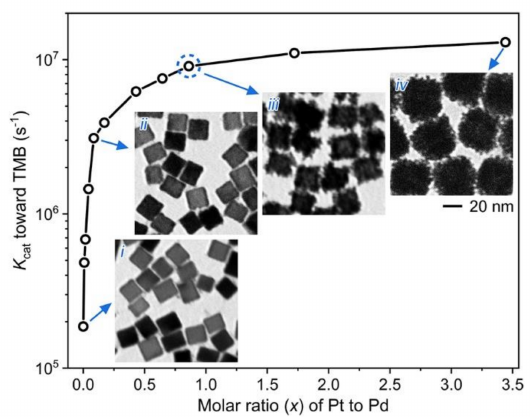
Figure 4. Effect of Pt content on the peroxidase-like catalytic efficiency of Pd@Pt NDs. A plot comparing the K cat values toward TMB of Pd@Pt NDs with different molar ratios ( x ) of Pt to Pd (i.e., Pd@Pt x NDs, x = 0–3.44). Insets show the TEM images of four representative Pd@Pt x NDs with x = 0 (i), 0.0860 (ii), 0.860 (iii), and 3.44